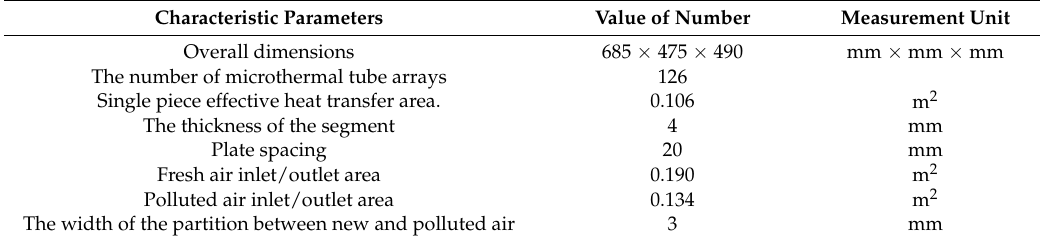
Figure 8. Simulation diagram of the micro-heat pipe heat exchanger, unit: mm. Table 1. Characteristic parameters of the heat